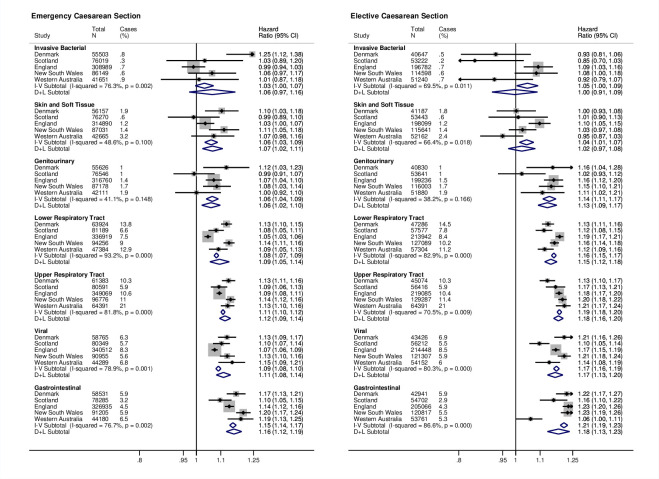
Site-specific and meta-analysis HRs for infection-related hospitalisations by clinical infection group. Estimates are from recurrent events models fitted for total time. Models adjusted for sex, gestational age, birth weight z-score, smoking during pregnancy, maternal age at birth, parity, area level deprivation, birth year, medical indication for type of delivery, and season of birth. Reference is vaginal births. CI, confidence interval; D+L, DerSimonian and Laird random effects model; HR, hazard ratio; I-V, inverse-variance weighted fixed effects model.